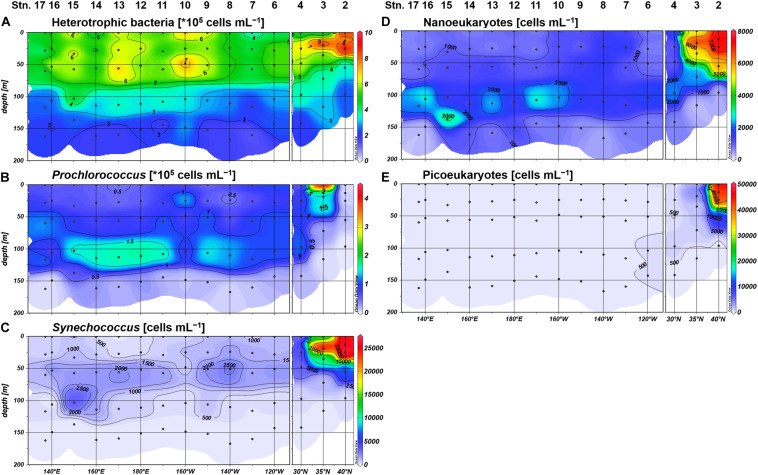
Distributions of the cell abundances of (A) heterotrophic bacteria, (B)
Prochlorococcus, (C)
Synechococcus, (D) nanoeukaryotes, and (E) picoeukaryotes.